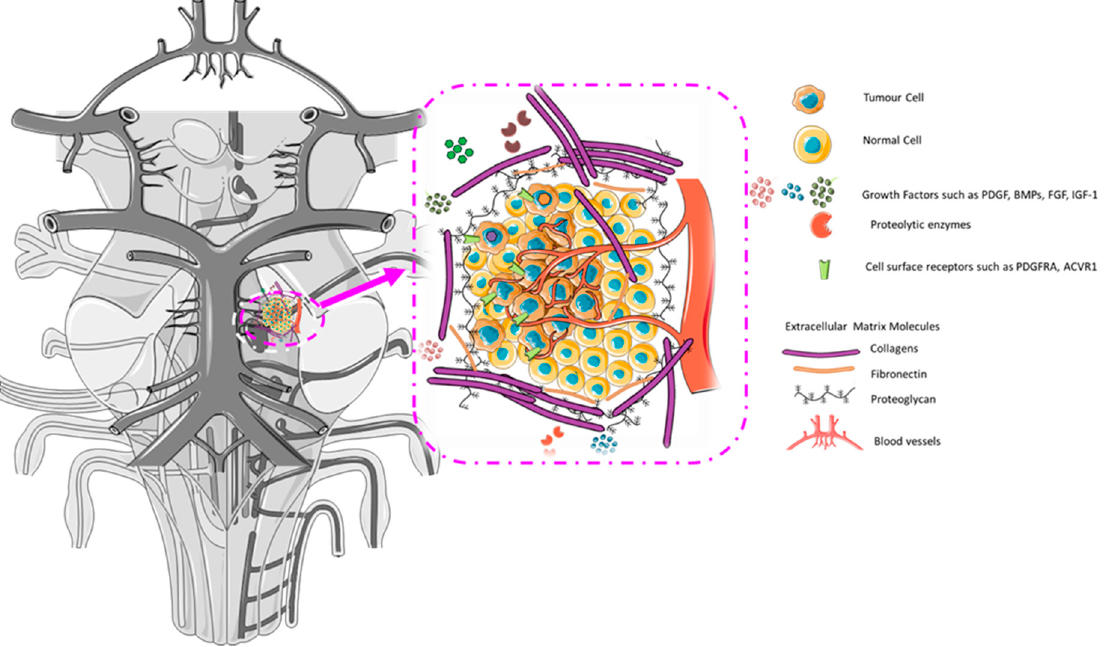
Figure 5. Schematic representation of the tumour microenvironment of a diffuse intrinsic pontine glioma (DIPG) in the context of the brainstem. Paediatric brain tumours form in the context of the developing CNS, adding an extra layer of complexity compared to adult brain tumours. By understanding the signalling pathways that govern brainstem development and the way they interact with the tumour, we can try to dissect the drivers of growth and resistance. Not depicted are microglia, immune components, and neural satellitosis.